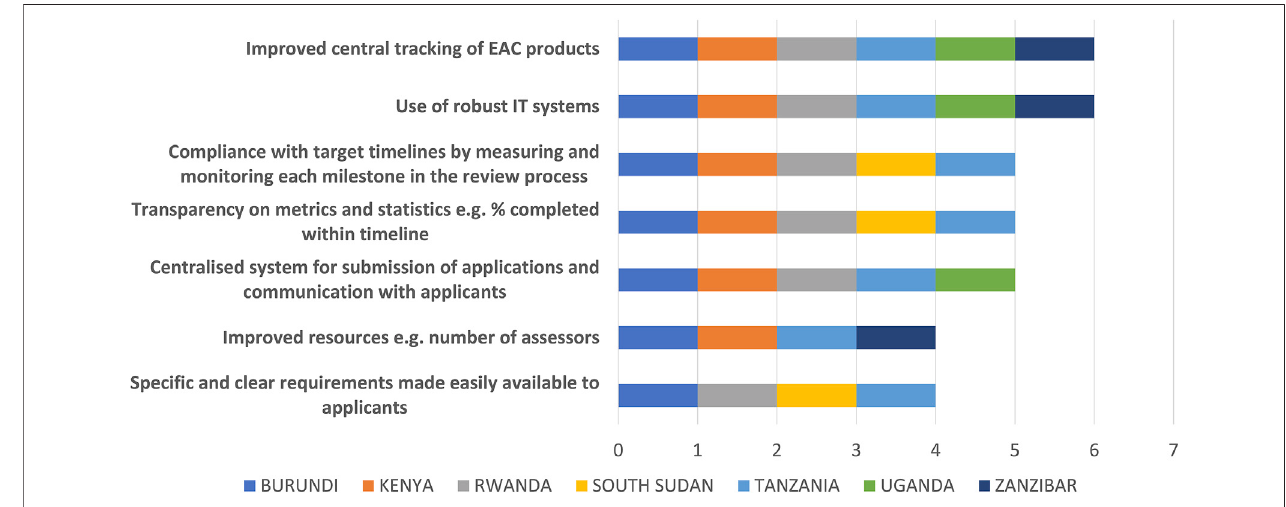
FIGURE 7 | Ways to improve ef fi ciency of the EAC-MRH